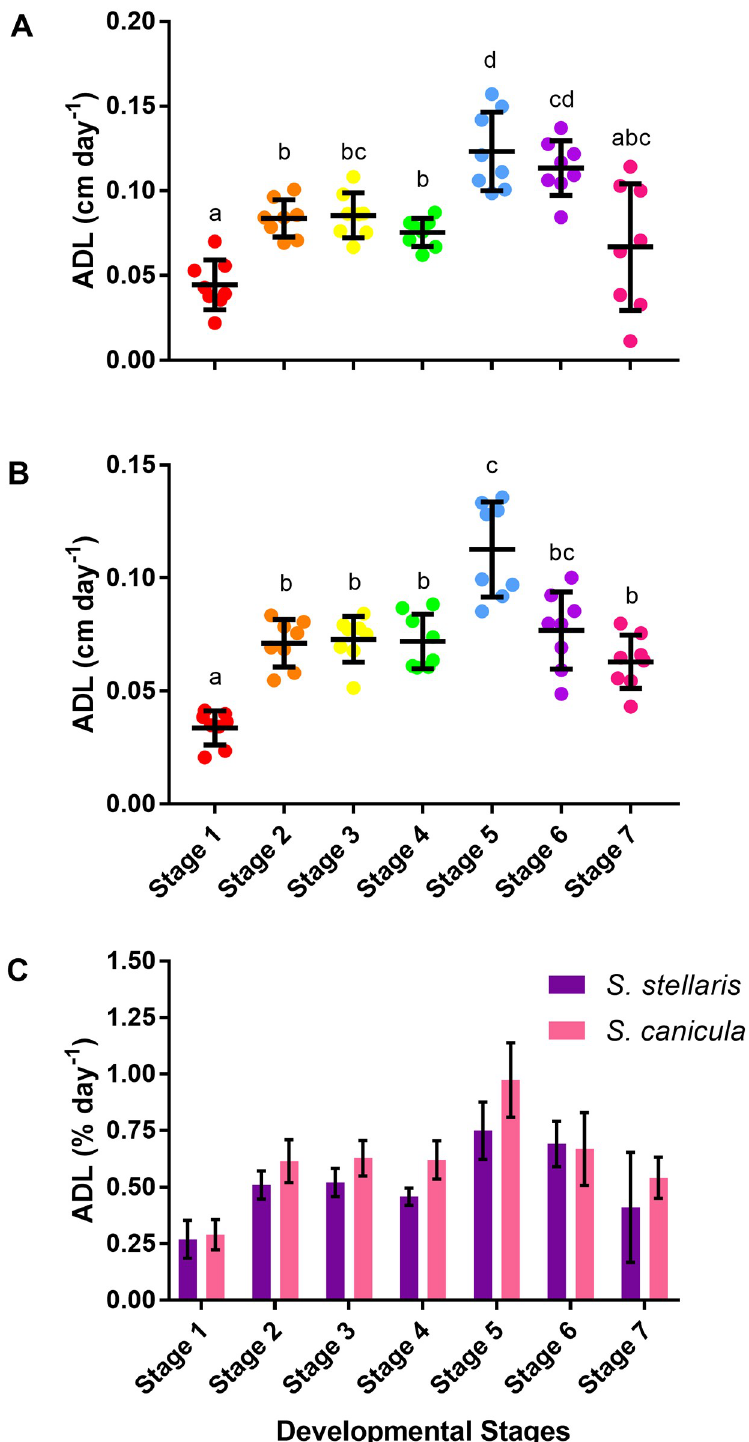
Fig 10. Average daily body length gain (ADL) during each of the 7 developmental stages. A: ADL (cm day -1 ) of S . stellaris embryos during each developmental stage. Lines show mean ± SD (n = 8), while points show measurements from each individual. Dissimilar letters indicate statistical differences between stages (RM one-way ANOVA, P < 0.05). B: ADL (cm day -1 ) of S . canicula embryos during each developmental stage. Lines show mean ± SD (n = 8), while points show measurements from each individual. Dissimilar letters indicate statistical differences between stages